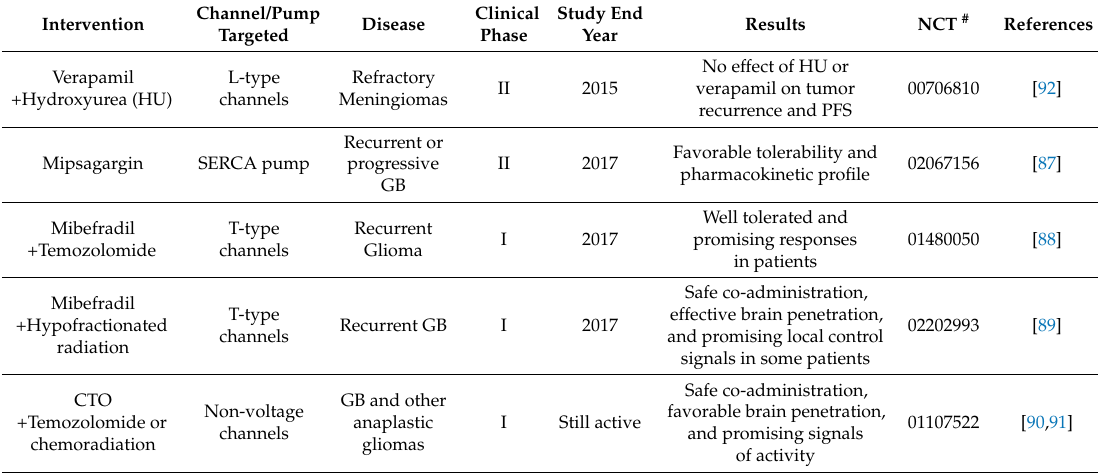
Table 2. Modulators of Ca 2+ -regulating proteins in clinical trials for treatment of brain cancers.